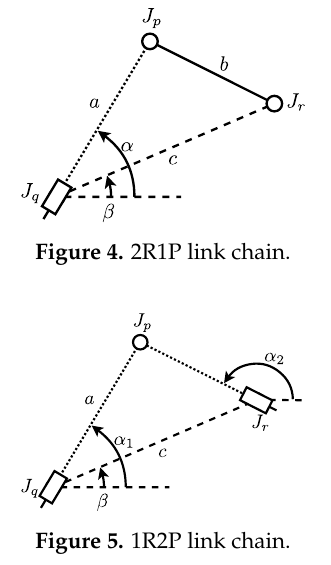
Figure 5. 1R2P link